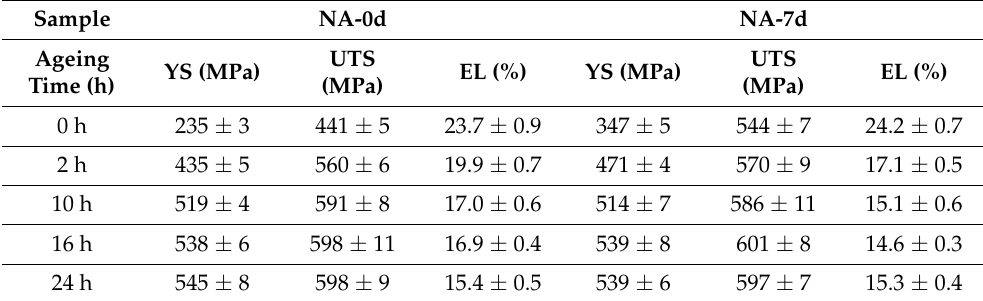
Figure 2. Tensile tests of ( a ) NA-0d and NA-7d samples and ( b ) NA-0d and ( c ) NA-7d samples aged at 120 °C for 2h, 10 h, 16 h, and 24 h. Table 2. YSs, UTSs and ELs of Alloys NA ‐ 0d and NA ‐ 7d aged at 120 °C for 0, 2, 10, 16, and 24 h.